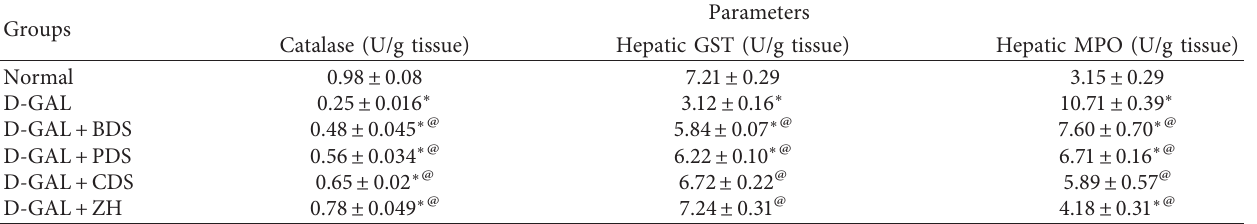
Table 3: Effect of D. salina on hepatic redox status biomarkers in albino rats with age-related hepatic steatosis.